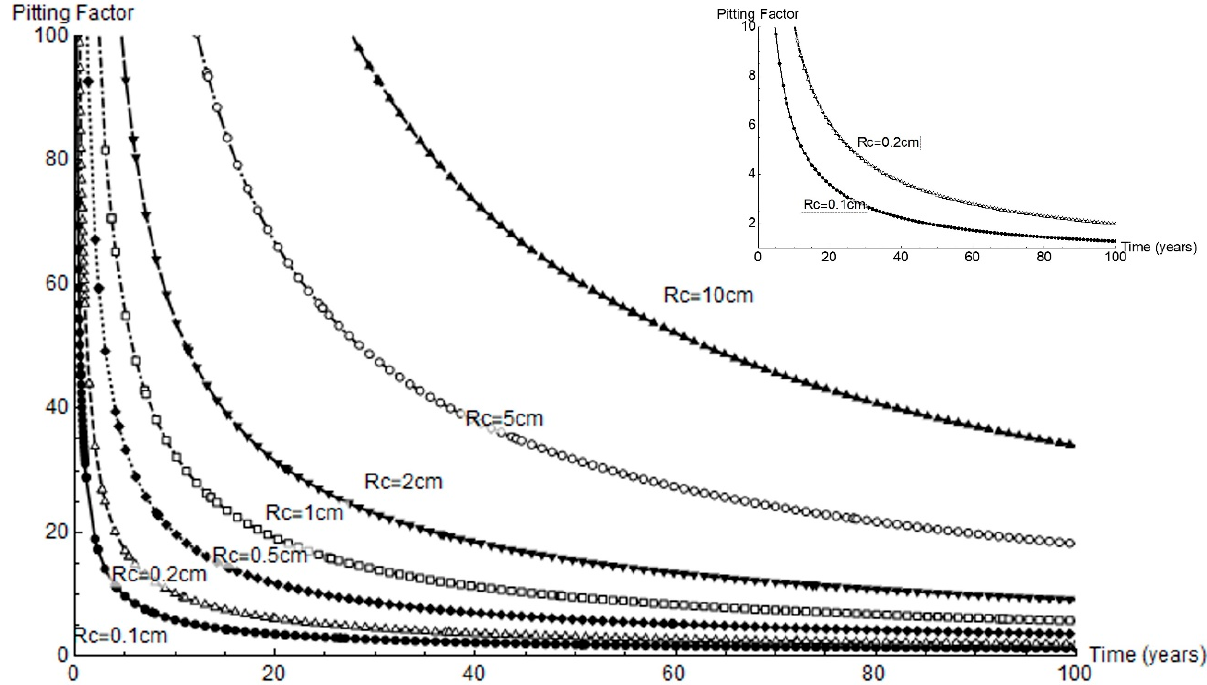
Figure 10. Variation in pitting factor over time for the geometries studied; right, variation for a cathode area with radius = 0.1 cm to 0.2 cm.